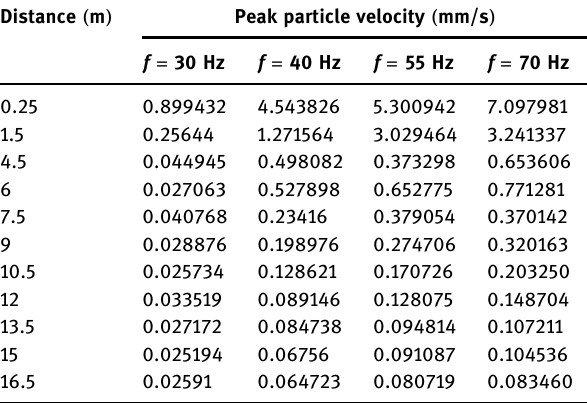
Table 8: The measured peak particle velocities at di ff erent locations for various frequencies ( active in - fi lled with 20% rubber trench barrier ) Distance ( m )